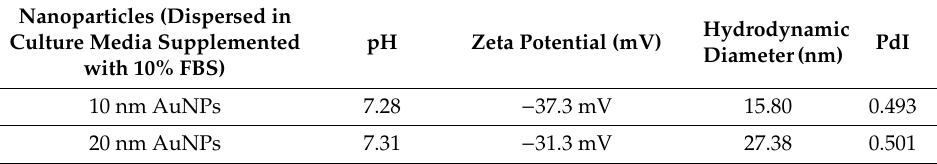
Figure 2. Representative images for the characterization of the ( A ) 10 nm and ( B ) 20 nm diameter AuNPs by TEM analyses of the monodisperse citrate-stabilized AuNPs and ( C ) UV-vis spectrometry. Table 2. The zeta potential measurements of two different-sized AuNPs.